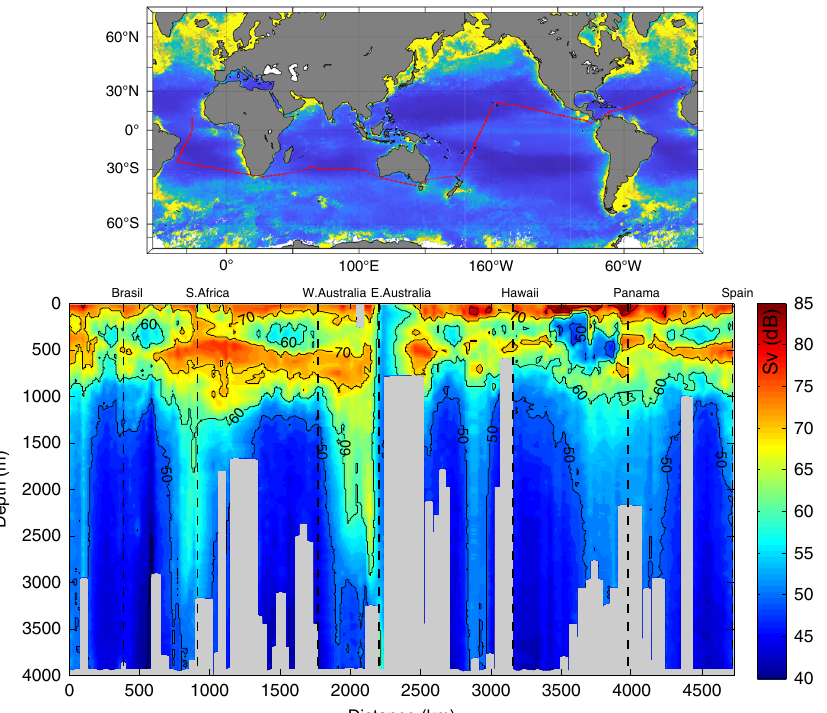
Fig. 3 Acoustic backscatter. Backscatter volume strength (SV) in dB obtained during the Malaspina Circumnavigation Expedition using the Lowered Acoustic Doppler Current Pro fi ler (LADCP) attached to the rosette sampler. Red line in the upper panel shows the Circumnavigation journey. Observe the deep scattering layer (DSL) all along the transect around 500 m depth, the almost absence of DSL in the oxygen minimum zone of the Paci fi c Ocean, and the global increase in backscatter at bathypelagic depths below areas of higher productivity approaching the continents (vertical dashed lines) and equatorial upwelling zones. The distance in the x -axis are the km from the beginning to the end of the